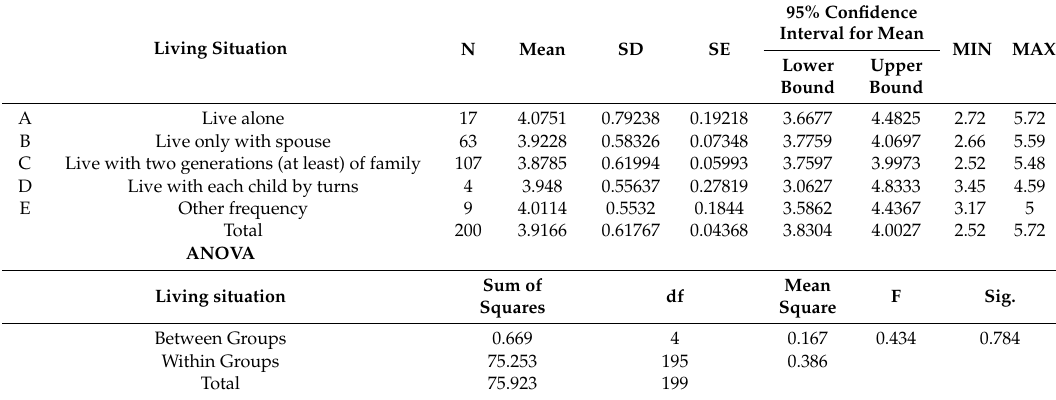
Table 5. ANOVA summary table for living situation distribution and the mean of